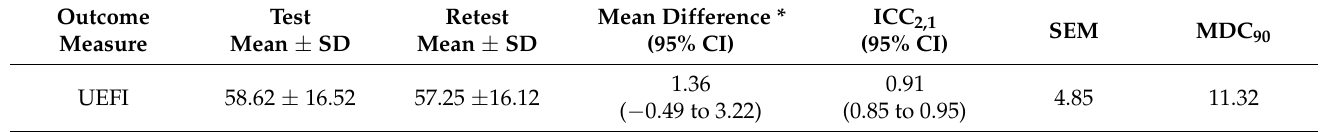
Table 2. Test–retest reliability and measurement error ( N = 55).